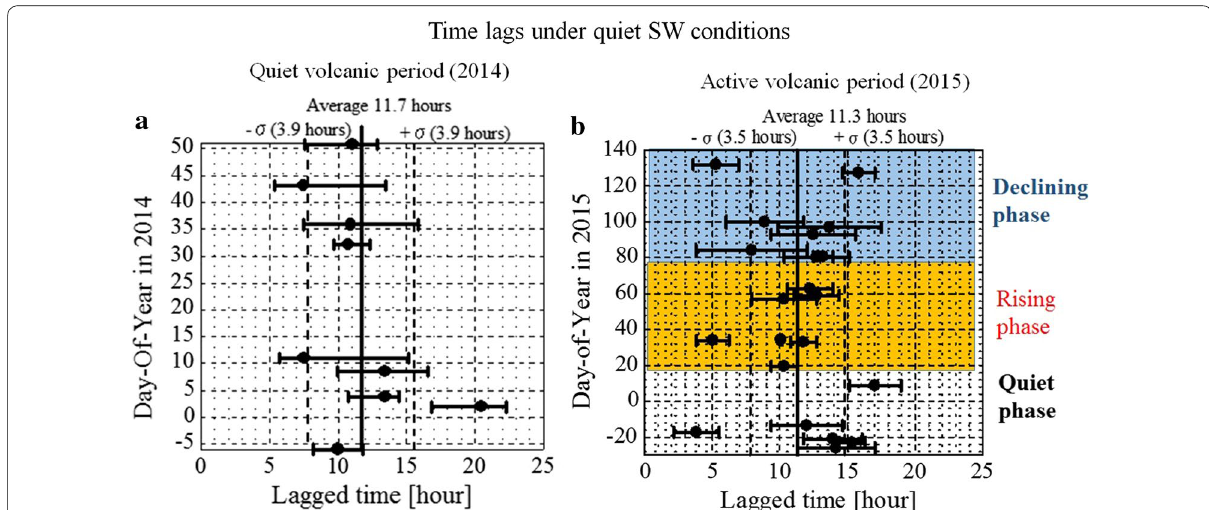
Fig. 6 a Time lags between brightenings of aurorae and those of the IPT. For volcanically quiet conditions in 2014, nine events were selected dur- ing which the IPT enhancements and internally driven aurora transients correlate. b Time lags under volcanically active conditions in 2015. With the same criteria applied as that used in the 2014 analysis, we detected 21 events as pairs of